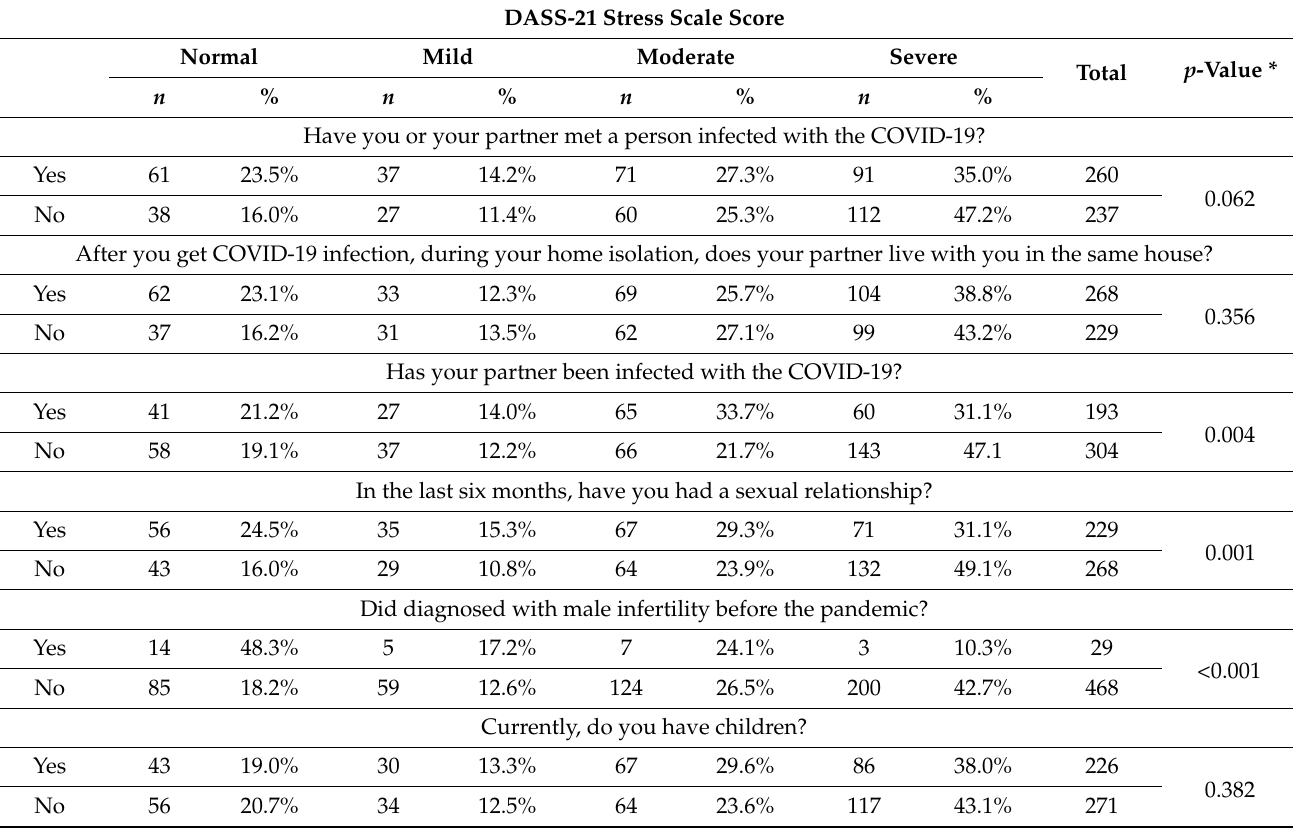
Table 4. Correlation between the DASS-21 stress scale score with partner relationship of COVID-19 responders during pandemic lockdown.